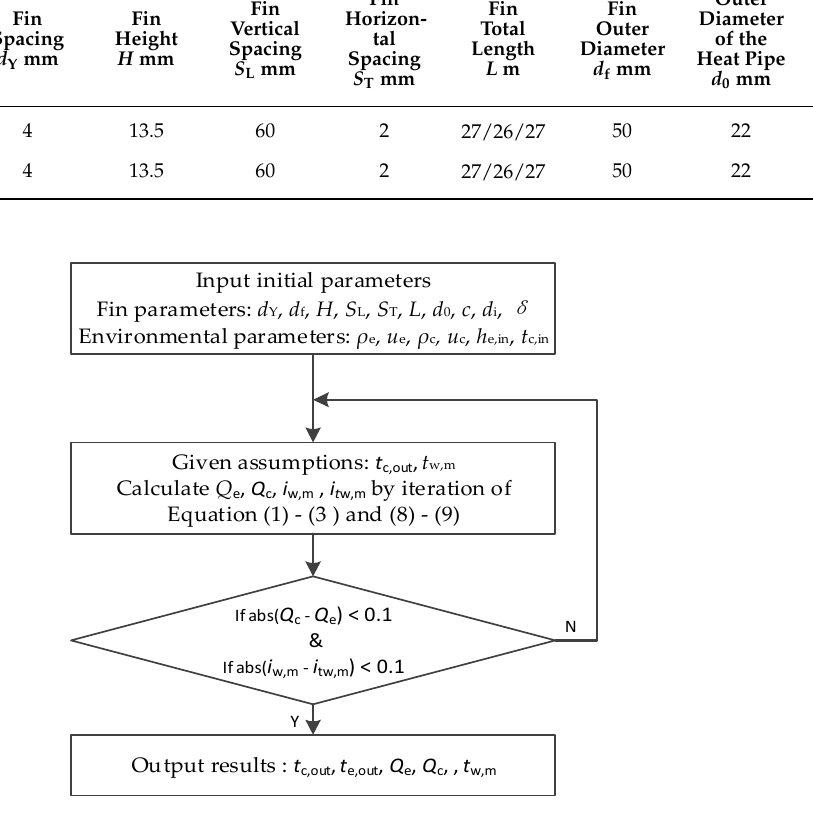
Figure 4. The procedure of optimization and calculation.